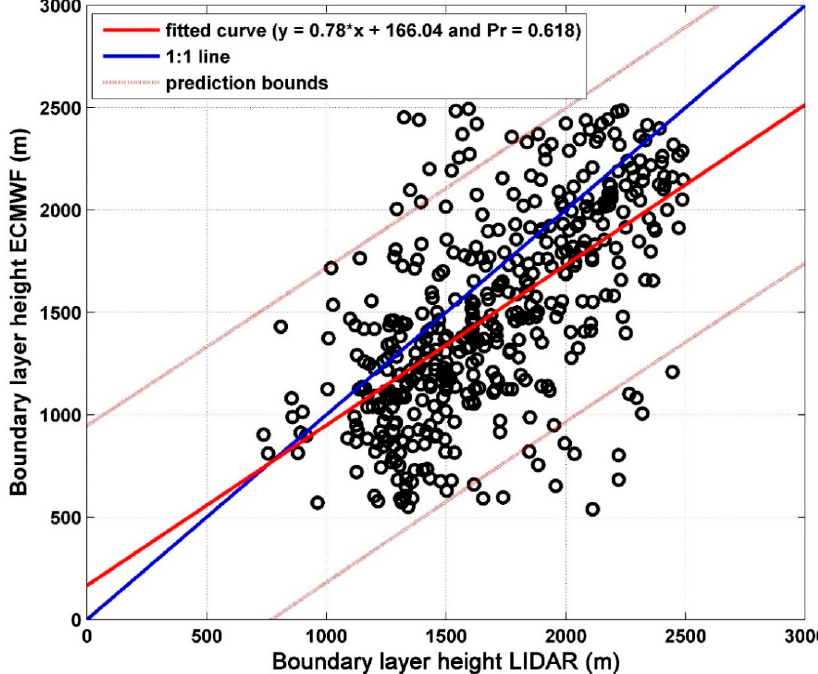
Figure 3. The BLH from ECMWF versus LIDAR on the site ‘CZ’ between 9 and 18 UTC. Blue, red line, red dashed line, and Pr represent the first bisecting, the linear regression, the prediction bounds and the correlation coefficient, respectively. Table 1. The classification of the air mass type (BL/AL or FT) sampled at the PUY station as a function of BLH/ALH, and Splitting Height (SH).